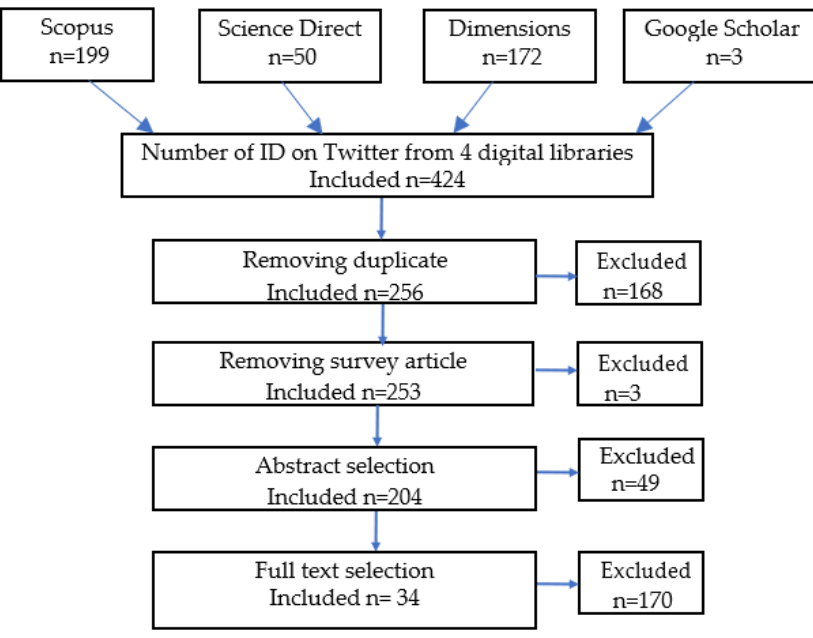
Figure 1. Diagram of the data selection